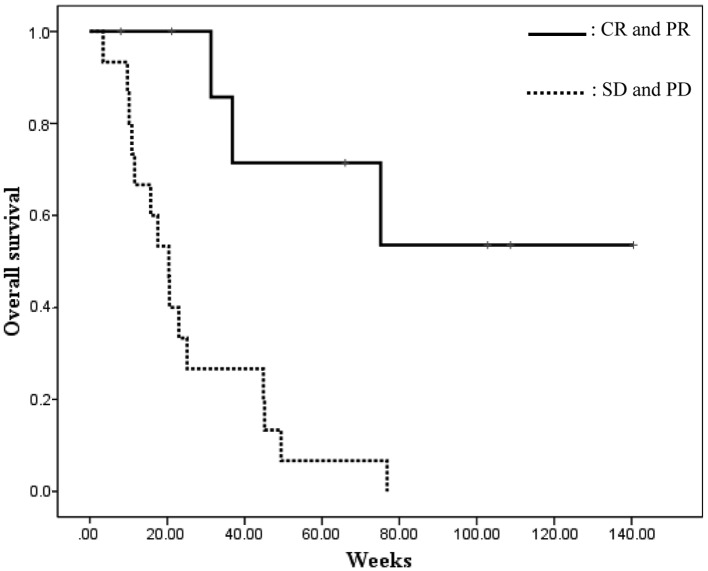
Kaplan-Meier survival plots for OS in advanced CRC treated with cetuximab monotherapy according to the evaluation of efficacy. OS, overall survival; CRC, colorectal cancer; CR, complete response; PR, partial response; SD, stable disease; PD, progressive disease.